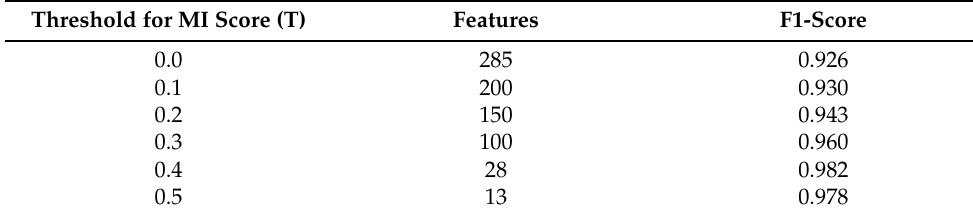
Table 3. Performance for MI thresholds.